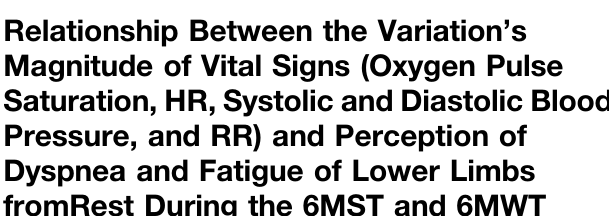
Frontiers in Physiology |